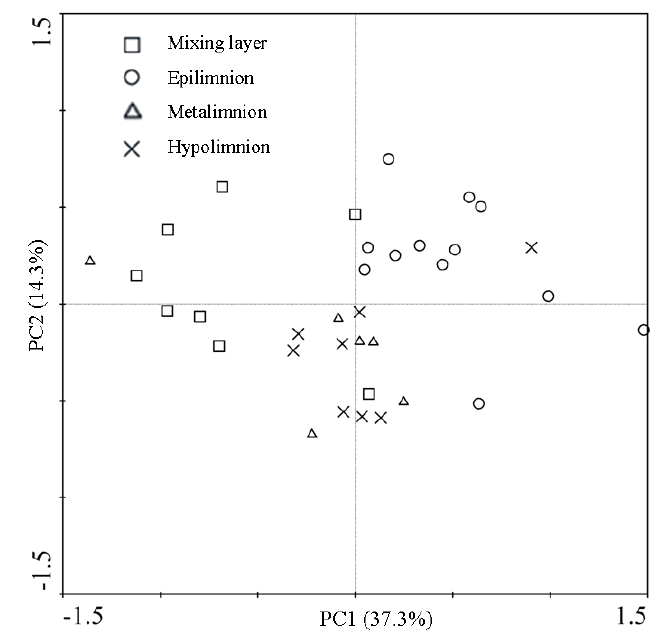
Figure 4. Principle component analyses (PCA) of the functional diversity of bacterial communities of each sample in the Jinpen Drinking Water Reservoir, China. Data were calculated based on sole carbon substrate utilization pattern using Biolog method at 144 h incubation time. Numbers in brackets represent the percentage of variation explained by each factor, PC1 explains 37.3% of the variance of the data and PC2 explains 14.3% of the variance in the data,